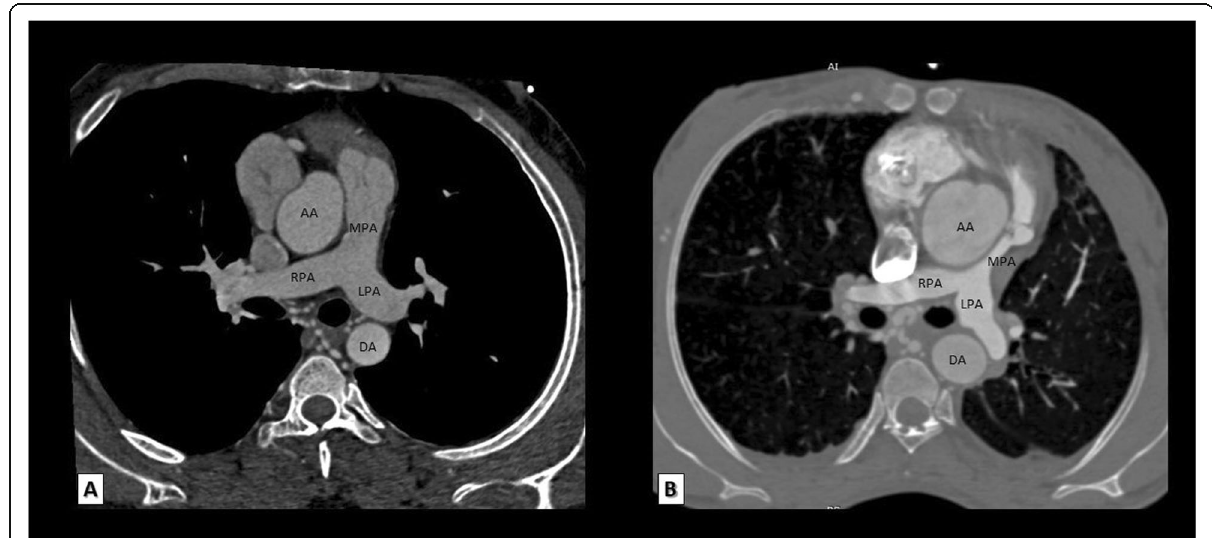
Fig. 1 Reformatted MDCT axial images of two different patients. The first patient with sizable main pulmonary artery as well as its right and left pulmonary branches ( a ) and the second patient with sizable right and left pulmonary arteries but with hypoplastic main pulmonary artery ( b ). AA, ascending aorta; MPA, main pulmonary artery; RPA, right pulmonary artery; LPA, left pulmonary artery; DA, descending